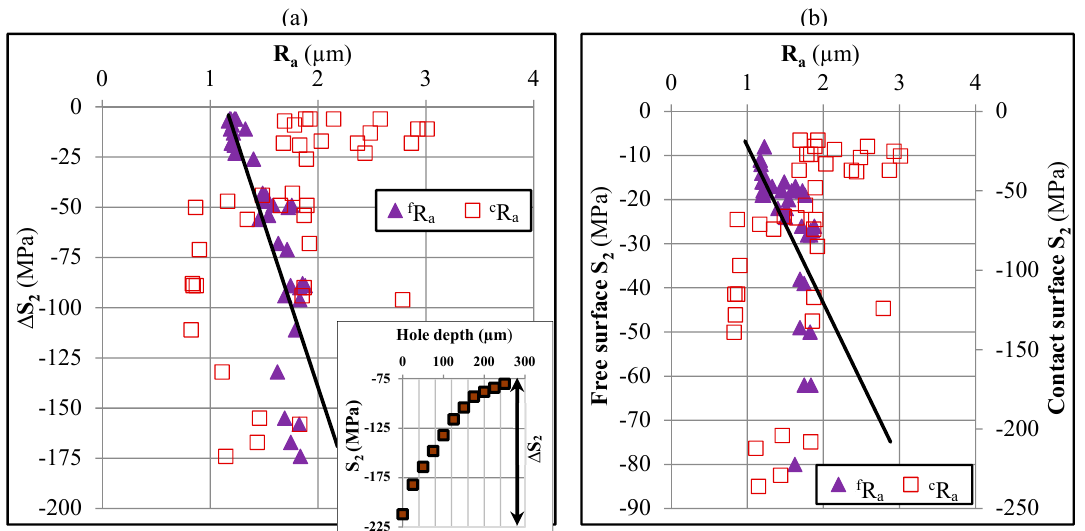
Figure 6. Correlation between the mean roughness and in-plane residual stress: ( a ) Stress gradient and ( b ) surface stresses.